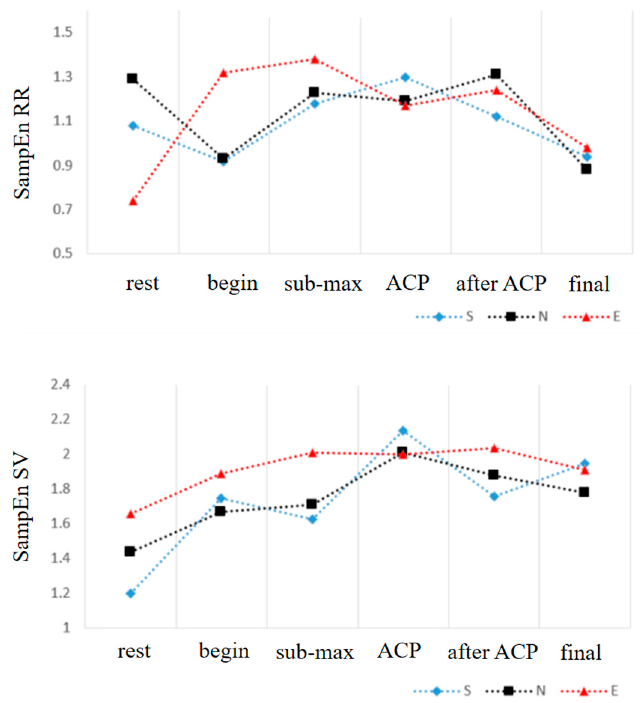
Figure 8. The results of SampEn RR and SampEn SV in the three